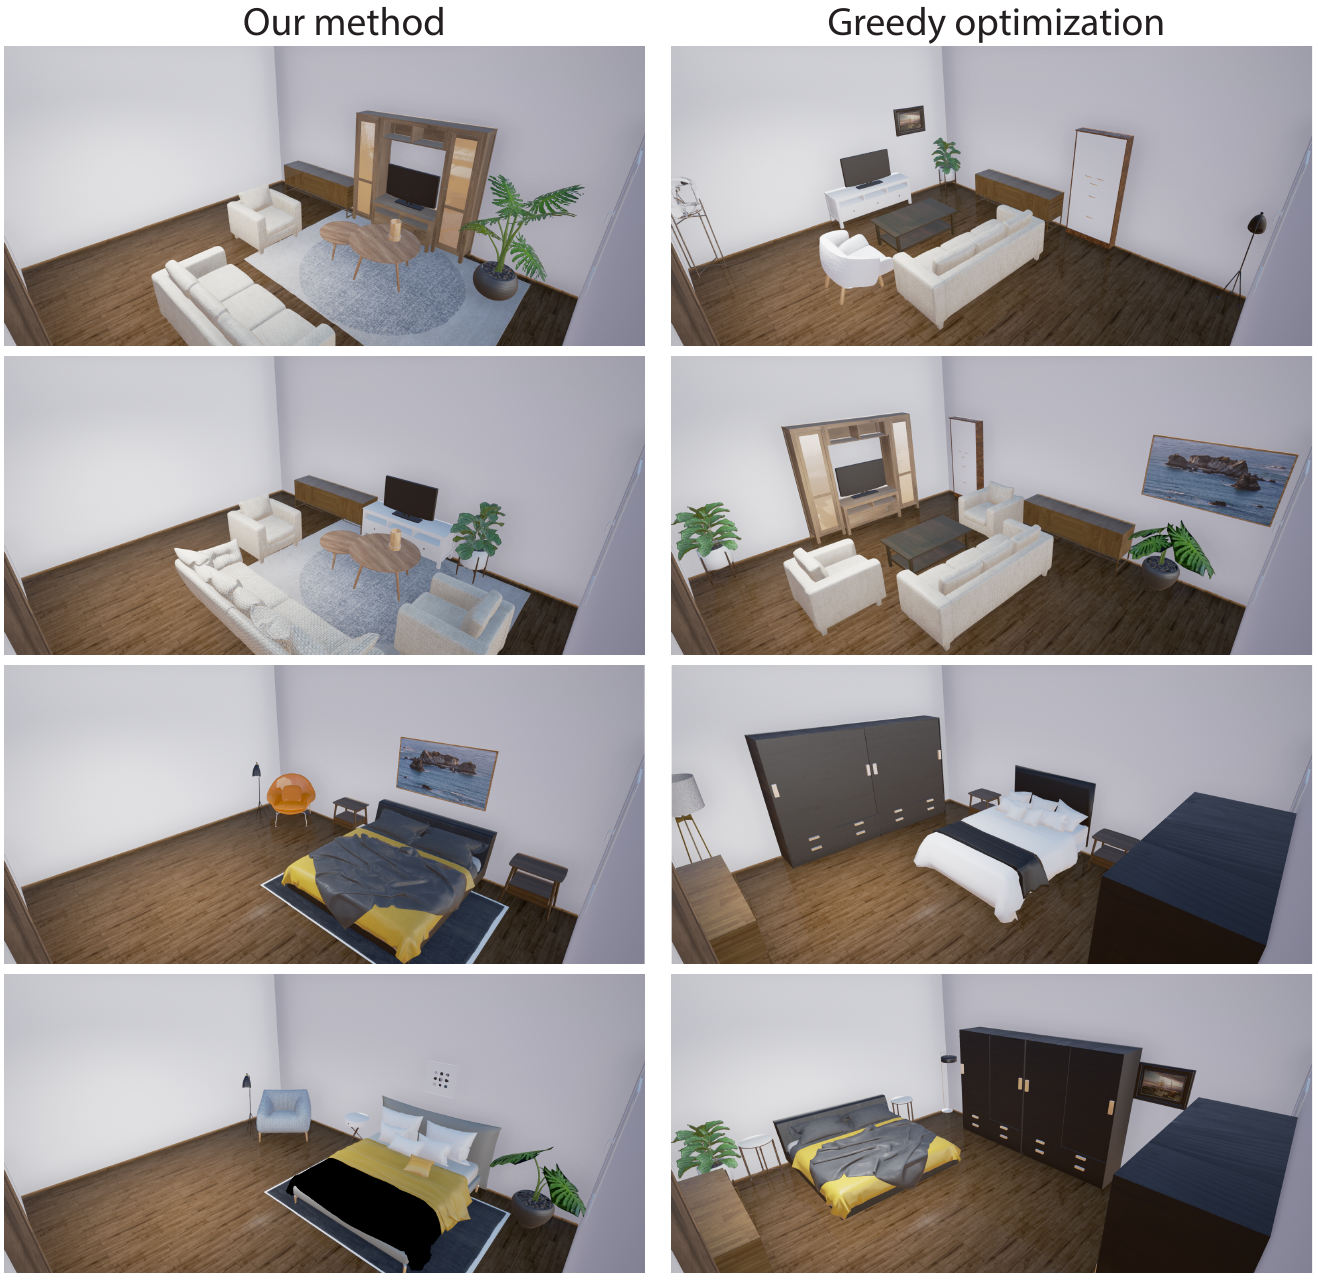
Figure 7. Automatically generated interior designs from our design preference study. Left column shows designs generated by our method while right column shows designs generated by compared optimization approach [5]. Interior designs were generated for two room types: living room and bedroom. In addition to these images, the users in our study saw an additional image per each furnished room, rendered from the opposite corner. This second image was used to provide a user with better overview and spatial understanding of the generated layout. Here, the second image is omitted for